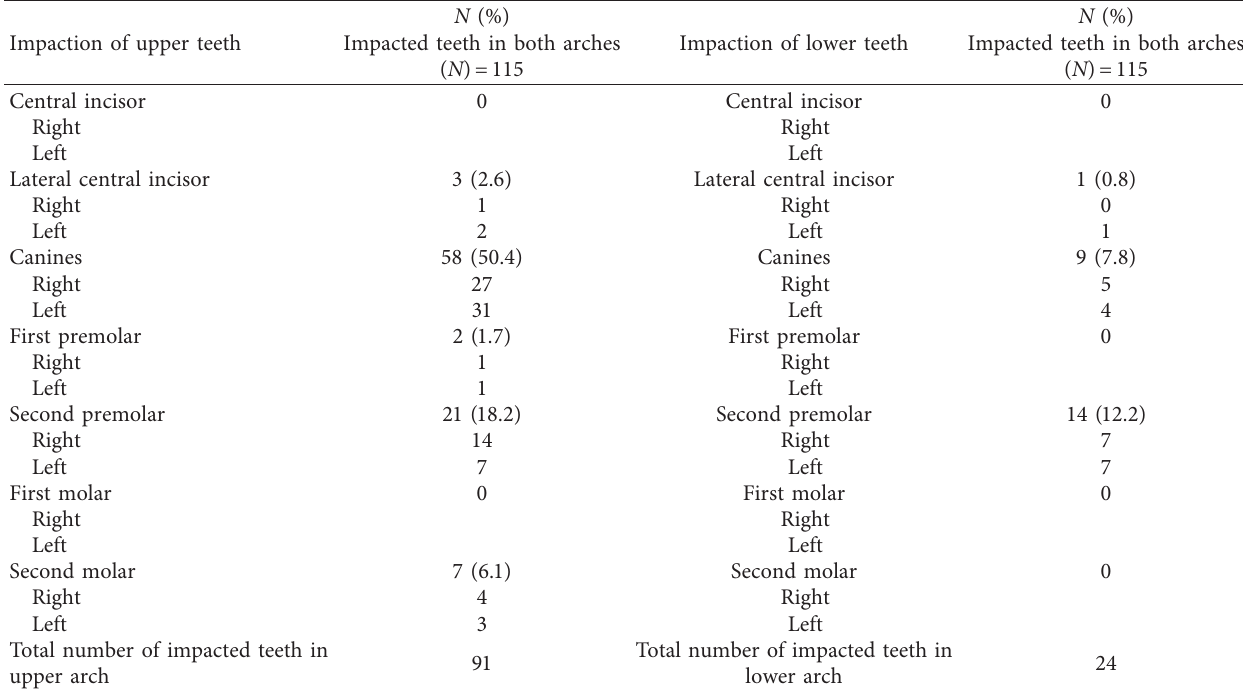
Table 2: Impaction of different teeth among study participants.